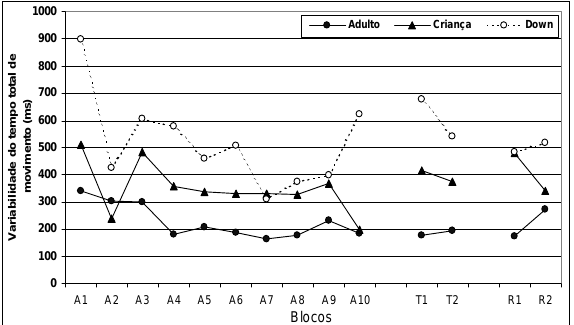
Figura 7 . Mediana da variabilidade do tempo total de movimento ao longo das fases para os três grupos.